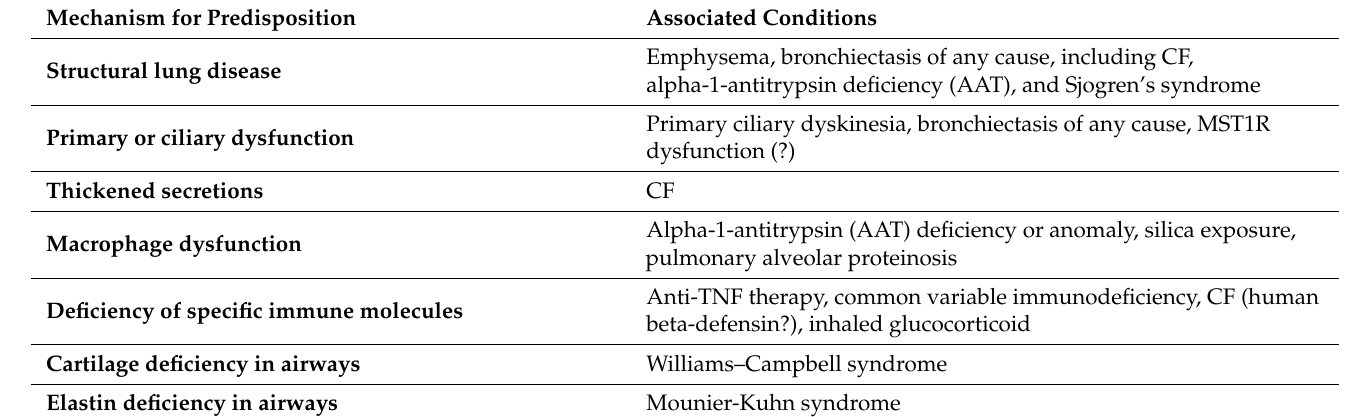
Table 1. Major known mechanisms that predispose to